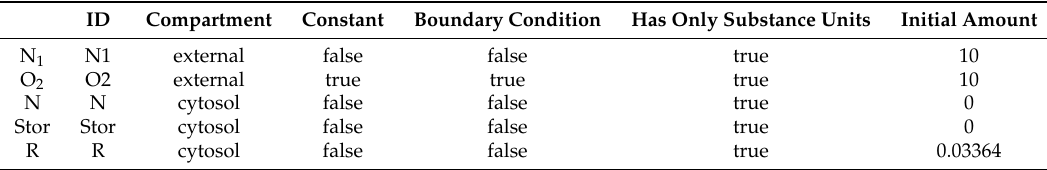
Table 4. Examples for setting species fields for each species